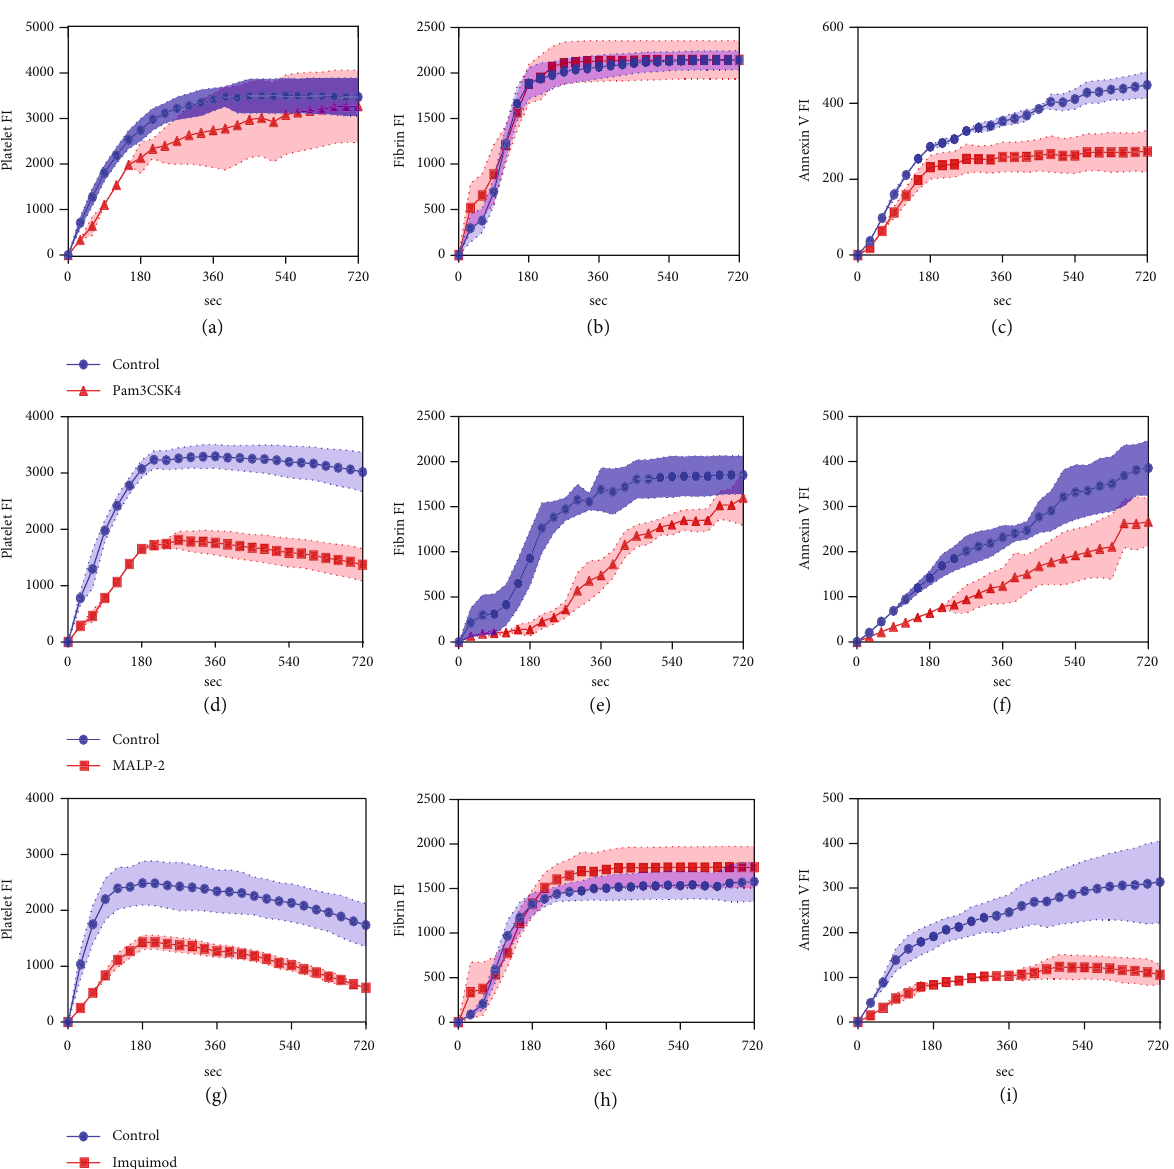
Figure 6: Pam3CSK4, MALP-2, and Imquimod can inhibit PS exposure under fl ow. High CTI WB with HBS (control) or di ff erent TLR ligands was perfused over collagen at 100s -1 for 720 s. CD61, fl uorescence fi brinogen fl uorophores, and Annexin V fl uorophores were added to label for platelets, fi brin, and PS exposure, respectively. Platelet FI (a, d, and g), Fibrin FI (b, e, and h), and Annexin V FI (c, f, and i) were measured throughout the course of the